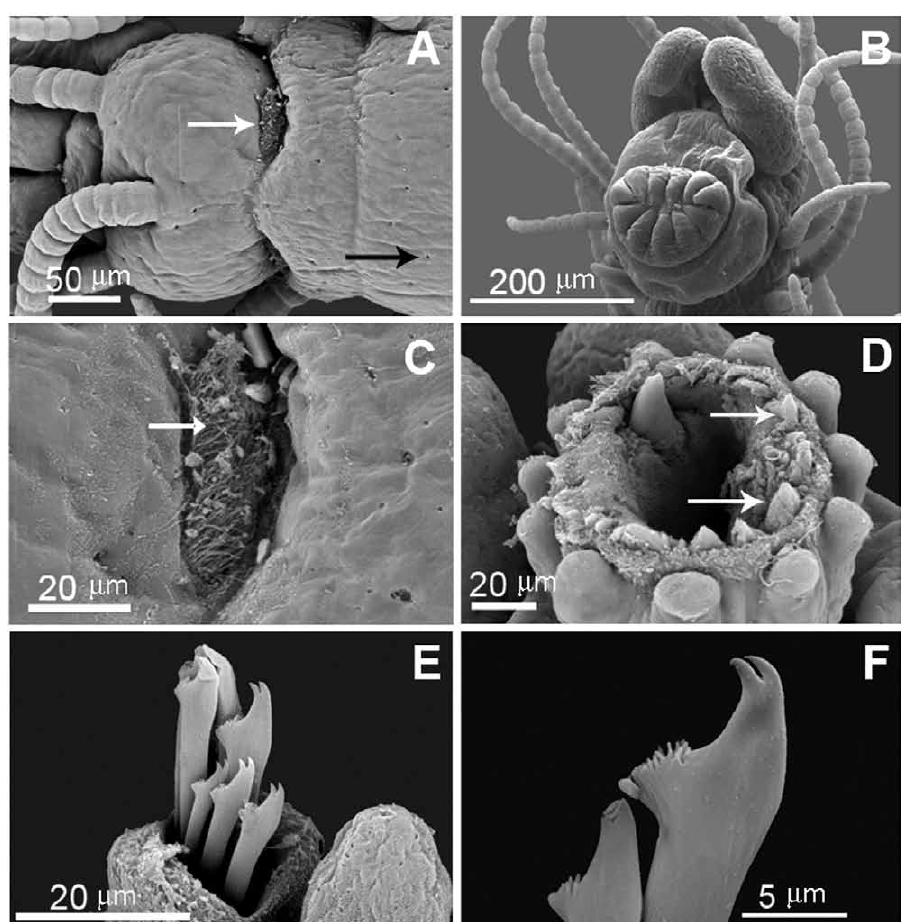
F IG . 6. – Geminosyllis granulosa sp. nov. A, anterior end, dorsal view, with the white arrow pointing to the nuchal organ and the black arrow to a pore hole; B, anterior end, ventral view; C, nuchal organs; D, pharynx and trepan, the arrows pointing to teeth; E-F simple bidentate mid-body Geminosyllis granulosa n. sp.